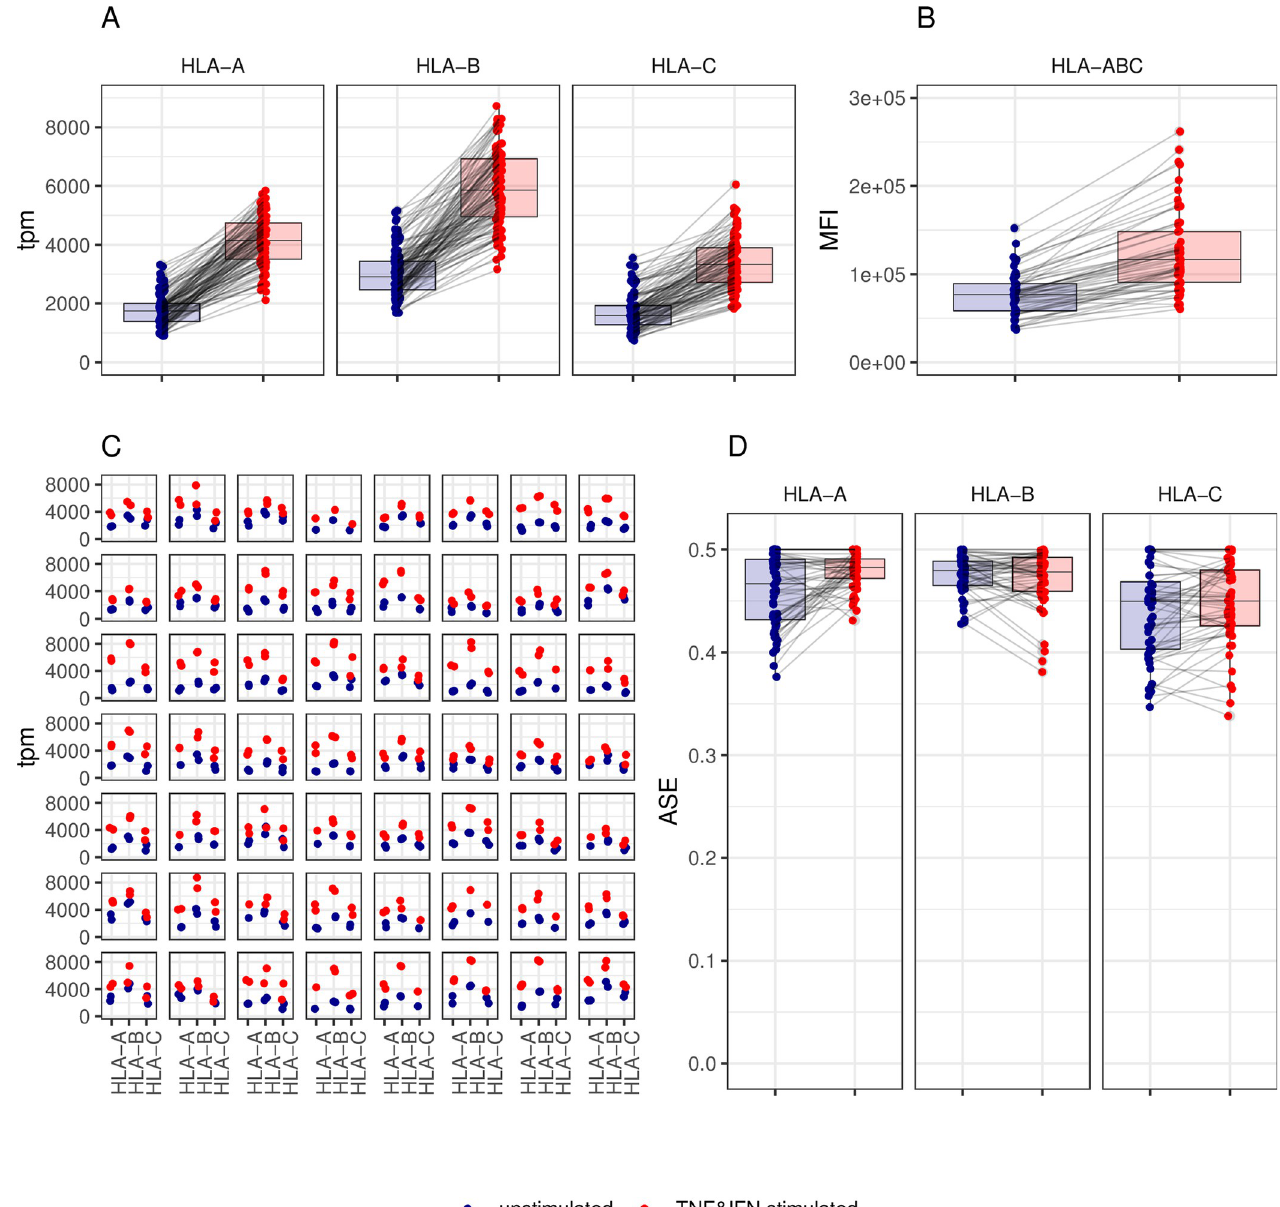
Fig 3. Upregulation of expression induced by TNF α and IFN β . Panel (A) RNA expression of HLA class I alleles (given as tpm) is plotted in 56 PBMC samples stimulated overnight with (red dots) or without (blue dots) pro-inflammatory cytokines TNF α and IFN β Each dot represents one allele of one PBMC sample. Panel (B) Cell surface expression of HLA-ABC as determined by flow cytometry is plotted and expressed as MFI for the same PBMCs tested just prior to RNA extraction. Panel (C) Allelic expression is plotted per locus (horizontal axis) and per individual. Each facet represents one individual, each dot one allele. The dots are colored according to the same code as in Panel (A). Panel (D) Allele specific expression (ASE) at the three HLA class I genes is plotted according to both stimulation conditions.